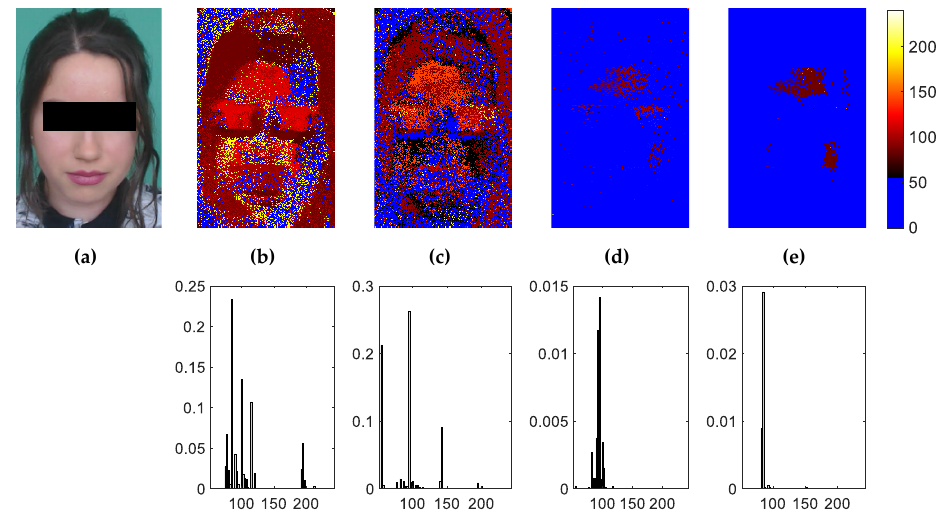
Figure 11. Prediction maps (subject #1, 60 first frames) for different training epochs. ( a ) Video stream excerpt (face close-up). Map for ( b ) epoch #25, ( c ) epoch #45, ( d ) epoch #100, ( e ) epoch #1000. The corresponding normalized histograms are presented in the bottom row. We can visually observe that the pixels labeled with pulse rates converge into relevant areas, while pixels that contain no PPG information are properly